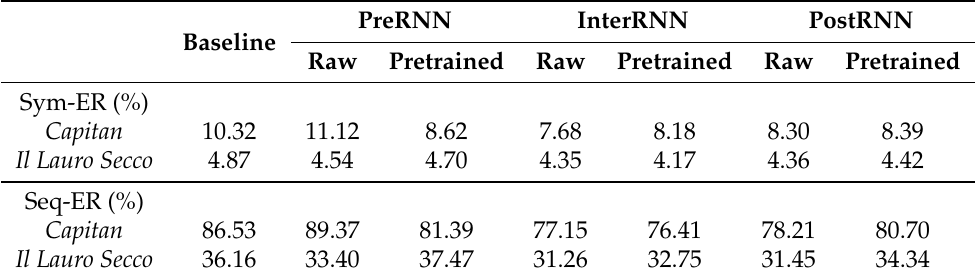
Table 3. Results obtained in terms of the Symbol (Sym-ER) and Sequence (Seq-ER) Error Rates comparing the base neural model with the different architectures proposed for the Σ T vocabulary case. Pretrained and raw denote the cases in which shape and height branches have been trained or not before considering the joint model,